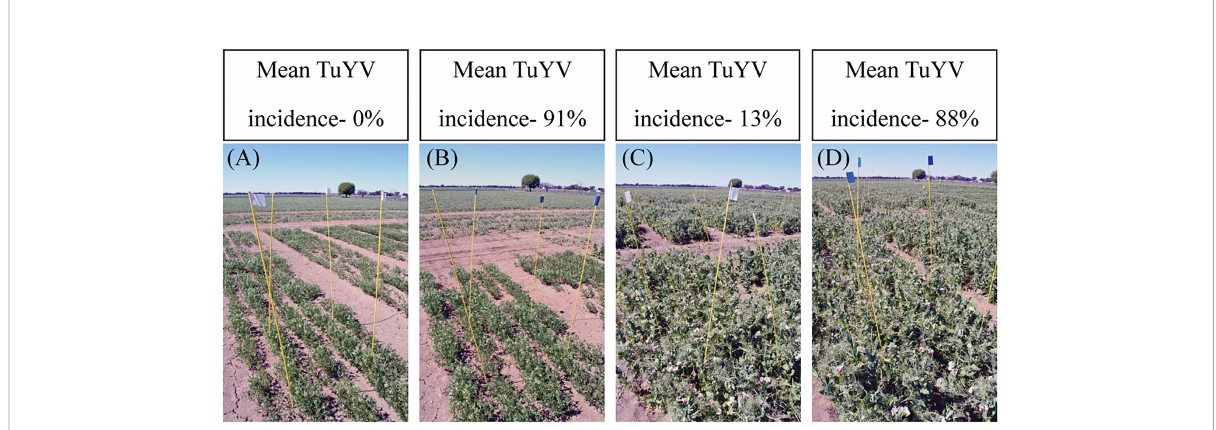
FIGURE 2 The lack of obvious symptoms of virus infection in: (A) non-inoculated control and (B) inoculated plots of lentil, and (C) non-inoculated control and (D) inoculated plots of fi eld pea in fi eld experiments conducted in south-eastern Australia during